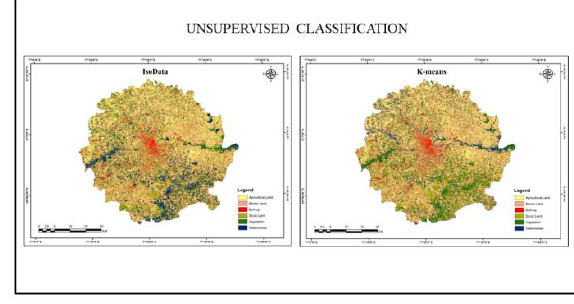
Figure 4. Unsupervised